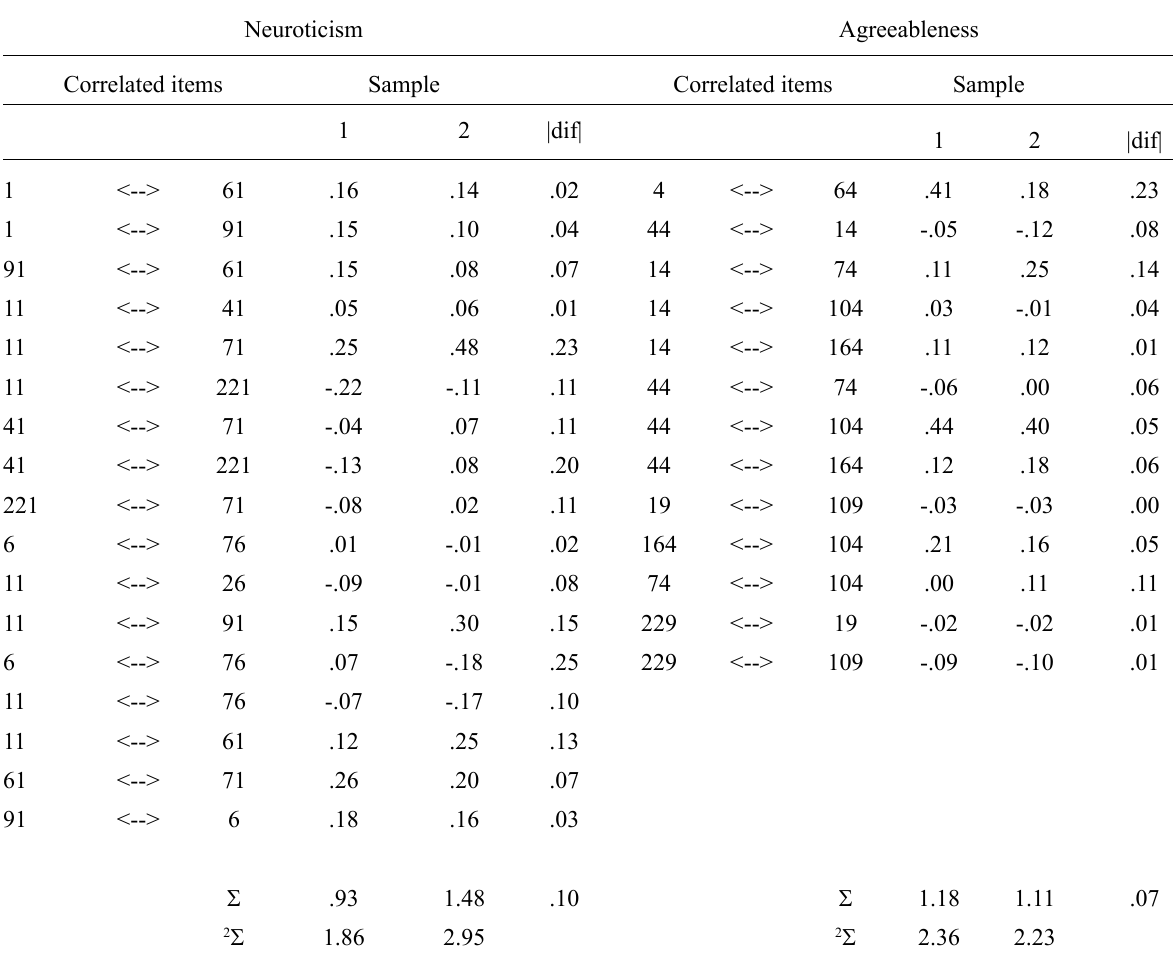
Table 7 Completely Standardized MLE Residual Correlations for Satisfactory Fitting Single-Factor Models: Neuroticism, Agreeableness Neuroticism Agreeableness Correlated items Correlated items